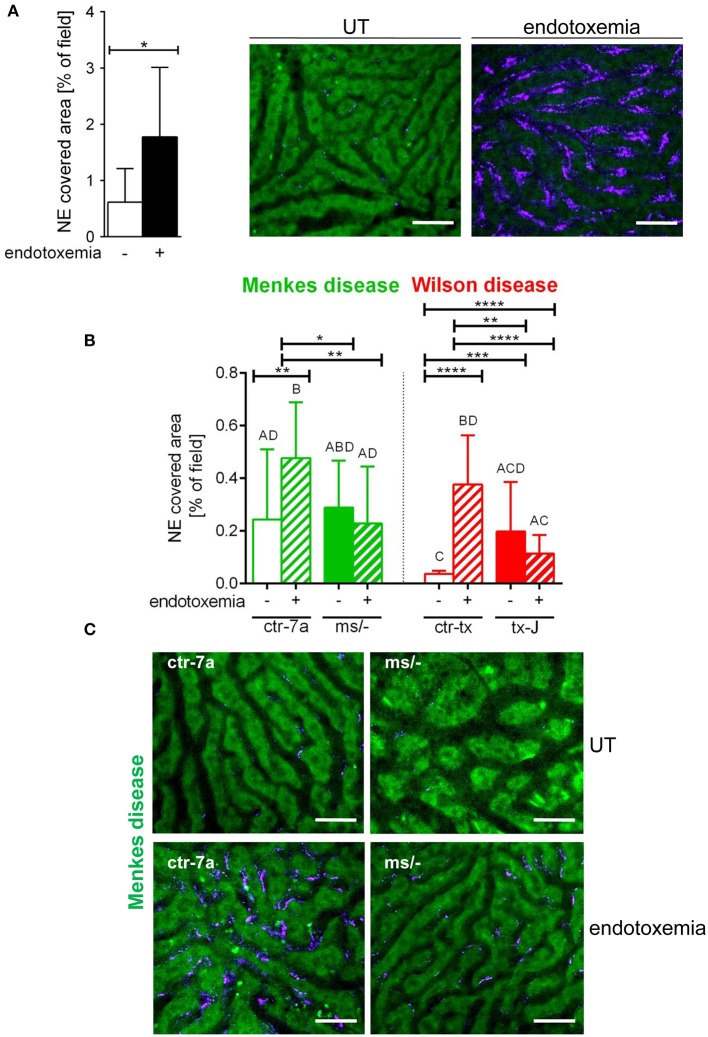
Deposition of neutrophil extracellular traps (NETs) in liver sinusoids during endotoxemia in C57Bl/6J mice (A) and in animals with Wilson (tx-J) and Menkes (ms/−) diseases and their respective controls — ctr-tx and ctr-7a (B,C). NET formation was quantified as the percentage of area covered by neutrophil elastase (NE) in each analyzed field of view (FOV) (mice n = 3/group). Asterisks indicate significant differences using unpaired two-tailed Student's t test (*P ≤ 0.05, **P ≤ 0.01, ***P ≤ 0.001, ****P ≤ 0.0001) in (A,B) or one-way ANOVA (post hoc Bonferroni) test in (B); different letters indicate statistically significant differences between groups. Representative pictures of NE deposition in livers of C57Bl/6J mice are presented in (A) and of Menkes disease mice and their littermates in (C) (images of Wilson disease mice and their controls are presented in Supplementary Figure 1). On images, autofluorescent hepatocytes (green) can be observed, and between them, sinusoids are seen as black areas. In the latter structures, NE signal is deposited along endothelium (violet). UT, untreated. The scale bar indicates 50 μm.